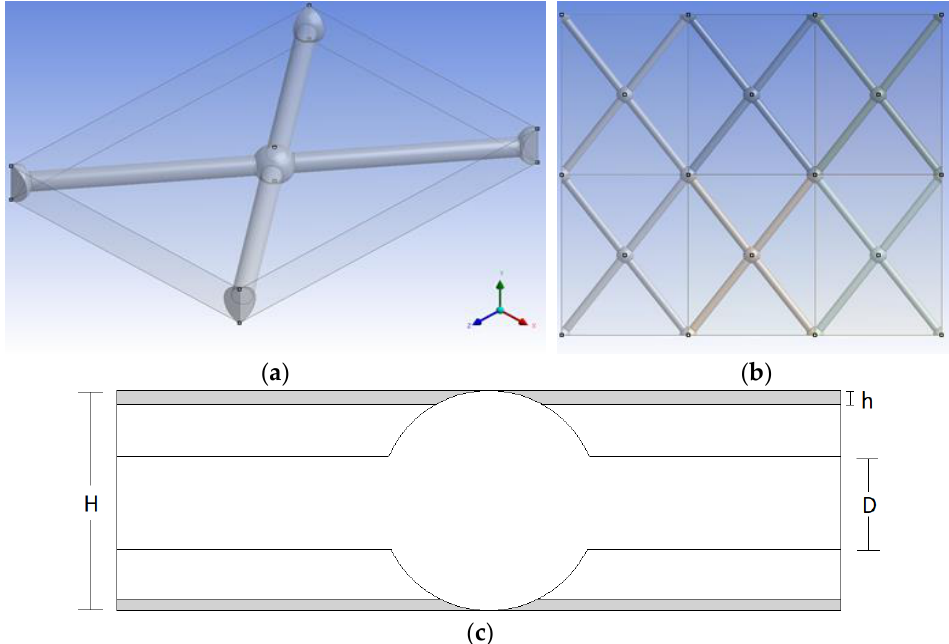
Figure 1. ( a ) The “unit cell” geometry for 3D simulations of the flow field and mass transfer. ( b ) Top view of the spacer pattern created by multiple unit cells; spacer between upper and lower membrane-bounding surfaces. ( c ) Cross-sectional view of membrane channel with spacer, indicating gap reduction h at each membrane surface, diameter of node (H) and of connecting filaments (D).